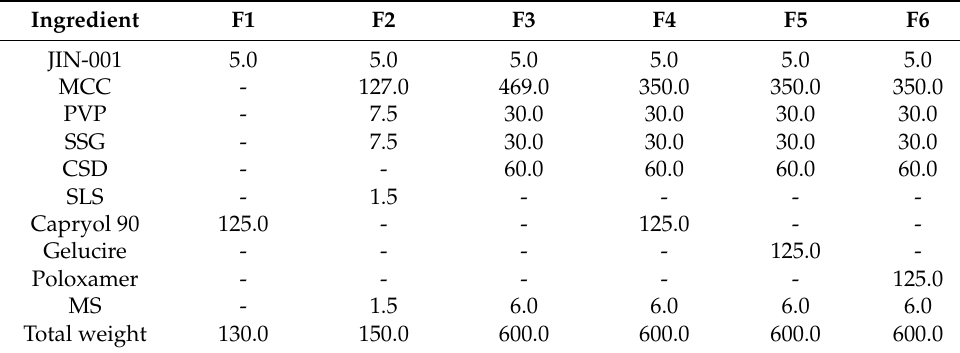
Table 7. Composition of JIN-001 formulations